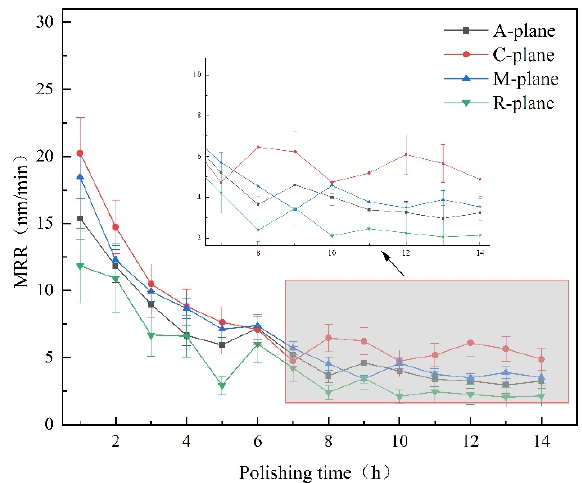
Figure 5 . Material removal rate (MRR) as a function of the polishing time of the four crystal orientations for the A-plane, C-plane, M-plane and R-plane.